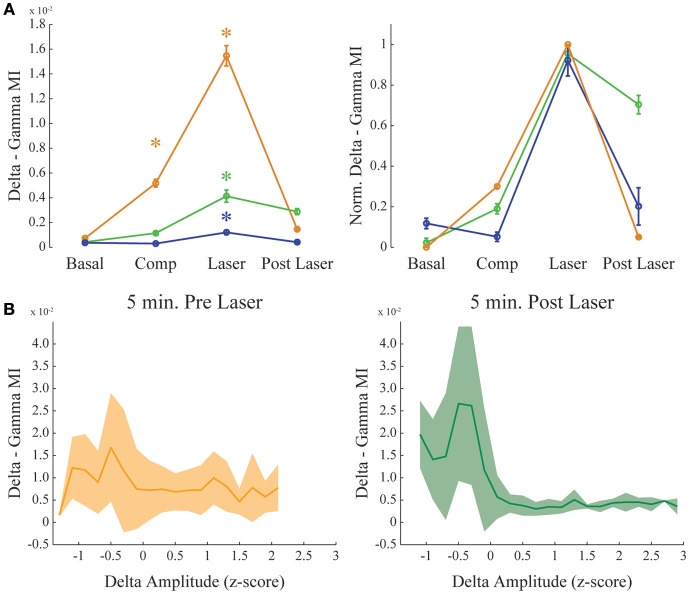
Dopamine increases delta-gamma comodulation. (A) Group result showing raw (left) and normalized modulation index (right) for the delta-gamma comodulation in the 4 different conditions of the experiment. Basal: recording immediately before beginning the injection. Comp: 10 min after compound injection. Laser: 1 min irradiation. Post Laser: 10 min after laser irradiation. Each color represents one animal, and all recording channels were pooled together per recording session. Friedman's statistical test, Tukey's post-hoc test (p < 0.05). Error bars represent SEM (N = number of channels for each animal; orange: 14 channels; green: 13 channels; blue: 10 channels). Asterisks represent statistically significant differences in comparison with basal recordings. (B) Group results comparing delta—gamma coupling 5 min before and after laser onset while controlling for normalized delta amplitude. Solid line represents the mean and shaded area the standard deviation.